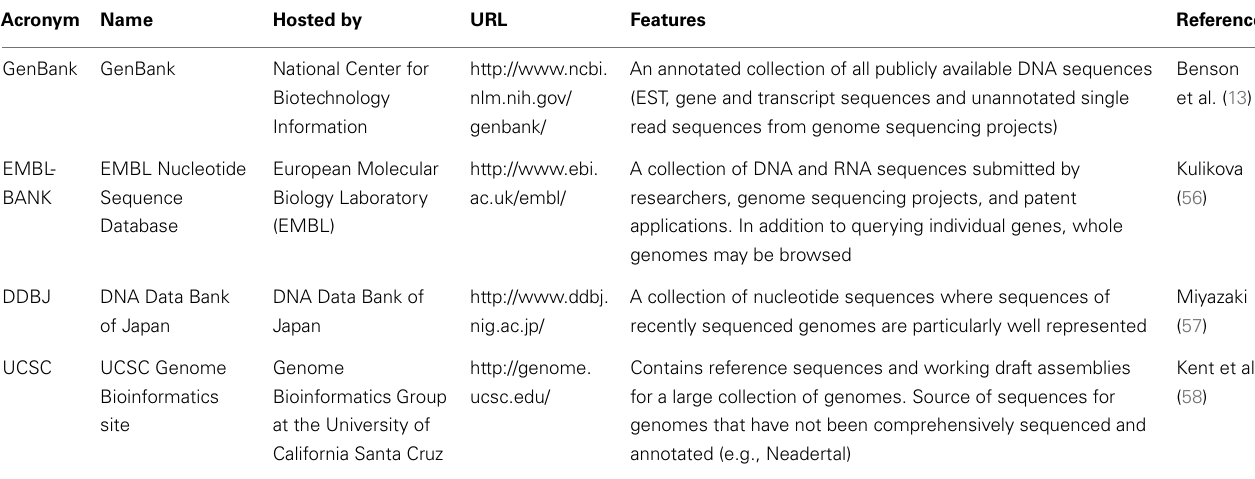
Table 1 | Public databases containing DNA, mRNA and protein sequences